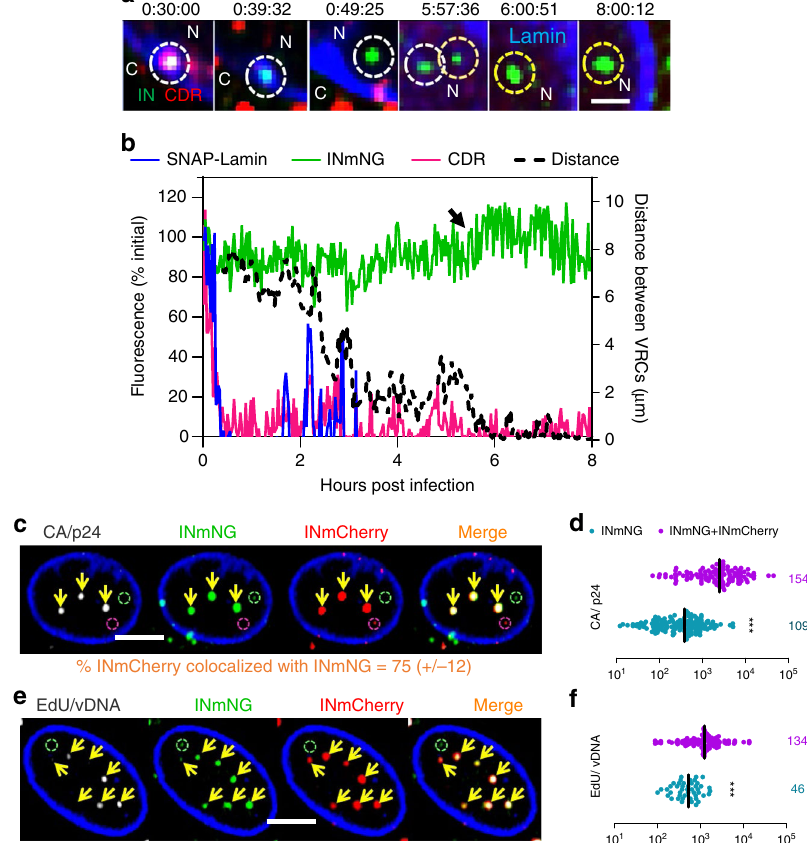
Fig. 1 Multiple HIV-1 complexes traf fi c to distinct nuclear locations in MDMs. a , b MDMs expressing SNAP-Lamin (blue) and infected at MOI 0.5 (corresponding to <30% infection of Vpx( + ) treated cells after 5 days) with VSV-G pseudotyped HIV-1 co-labeled with INmNG and CDR were imaged at 90 s/frame consisting of 15 Z-stacks for 0.5 – 8 h. a Single Z-slice images with time stamps showing an IN/CDR co-labeled particle (white dashed circle) docked at the nuclear envelope that loses CDR and enters the nucleus. After nuclear entry of a second IN-labeled complex (orange dashed circle), the two complexes traf fi c toward each other, merge (yellow dashed circles) and stay together till the end of the experiment (see Supplementary Movie 1). b Mean fl uorescence intensities of the single virus marked by white dashed circle in ( a ). The increase in INmNG signal at 6 h (arrow) represents merger of two nuclear IN complexes. Distance between the two IN complexes in ( a ) is plotted in the 2nd Y -axis (right). c – f Untreated MDMs were co-infected with HIV-1 labeled with INmNG or INmCherry markers at a total MOI of 1 for 24 h in the absence ( c , d ) or presence ( e , f ) of 5 μ M EdU. Cells were fi xed and immunostained for CA/p24 ( c , d ) or stained for EdU by click-labeling ( e , f ). c , e Images of a 2- µ m-thick central Z-projection of the MDM nucleus showing merged (double positive) VRC clusters colocalized with (yellow arrows) CA ( c ) and EdU ( e ). Single-colored INmCherry or INmNG VRCs are marked by red and green dashed circles, respectively. d , f Fluorescence intensities of CA and EdU of double- vs. single-color INmNG puncta are shown. Scale bars are 1 μ m in ( a ) and 5 μ m in ( c , e ). Data in ( d , f ) are presented as median values ± SEM at 95% CI (con fi dence interval). N > 50 nuclei from three independent donors/experiments. The total number of IN puncta analyzed is shown on the right. Statistical signi fi cance in ( d , f ) was determined using a